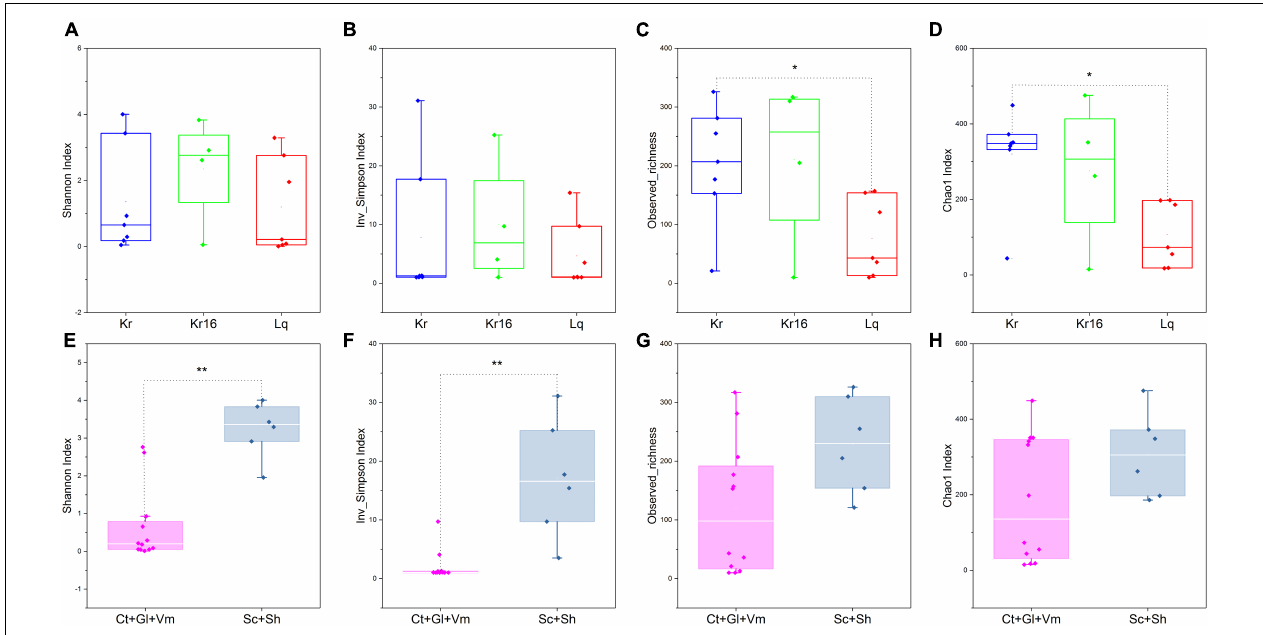
FIGURE 1 | Comparisons of four α -diversity indices, Shannon index (A,E) , Inverse Simpson index (B,F) , observed richness (C,G) , and Chao1 index (D,H) , of the SFS samples. Kr refers to SFS samples collected from the Kairei vent field; Kr16 refers to samples collected from the Kairei vent field SFS reared for 16 days; Lq refers to SFS samples collected from the Longqi vent field; The group of Ct, Gl, and Vm refers to the internal samples of SFSs; The group of Sc and Sh refers to the epibiotic samples of SFSs. *Difference is significant at 0.05 level; **Difference is significant at 0.01 level, based on Wilcoxon rank-sum test. The results based on the OTUs